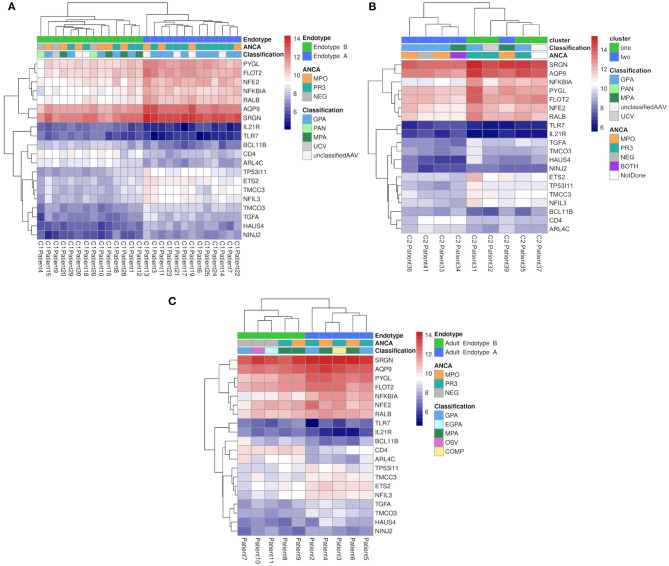
Hierarchical clustering of vasculitis patients based on expression data from 20 genes. Hierarchical clustering (hclust function of R) was performed using the average linkage method with Euclidean distances calculated from vst counts. The variance for all genes (as batch corrected vst counts) was calculated separately for major clusters. Genes with the lowest within-group variance, an absolute FC ≥ 2 between the clusters, the 50% least variable genes in both clusters, and an overall average count of at least 100 were selected and assessed for their ability to separate samples into the same clusters as the entire gene dataset. The heatmap represents expression (variance stabilized counts) of each of 20 genes (y-axis, right) that were (a) maximally divergent between Endotypes A and B (i.e.: significantly DE with a FDR adjusted p-value <0.05 and fold change >1.5) and (b) had low variance within each cluster to minimize the margin of error for testing individual samples. (A) Pediatric Cohort 1 patients (n = 27, x-axis) in Endotypes A (blue) and B (green). (B) Pediatric Cohort 2 patients (n = 9, x-axis) in relapse Endotypes A (blue) and B (green). (C) Adult patients (n = 10, x-axis) in Adult Endotypes A (blue) and B (green).